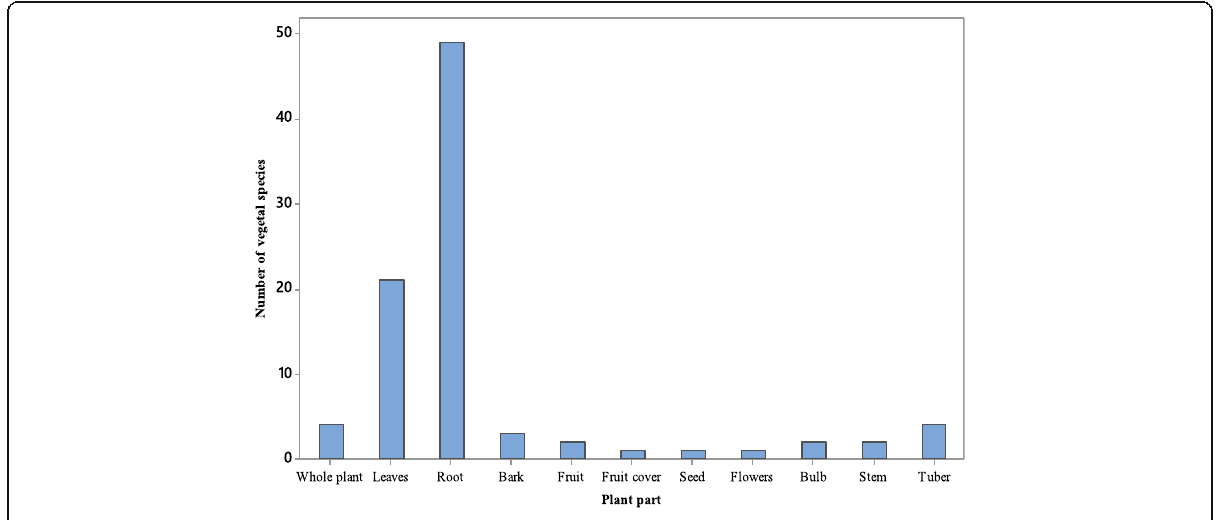
Fig. 5 Parts of antivenin plants used in rural communities of Uganda